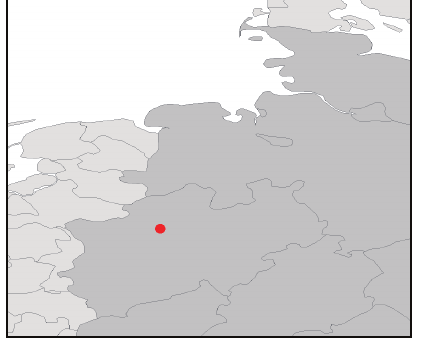
Figure 1. Location of the test sites within NRW (Germany)